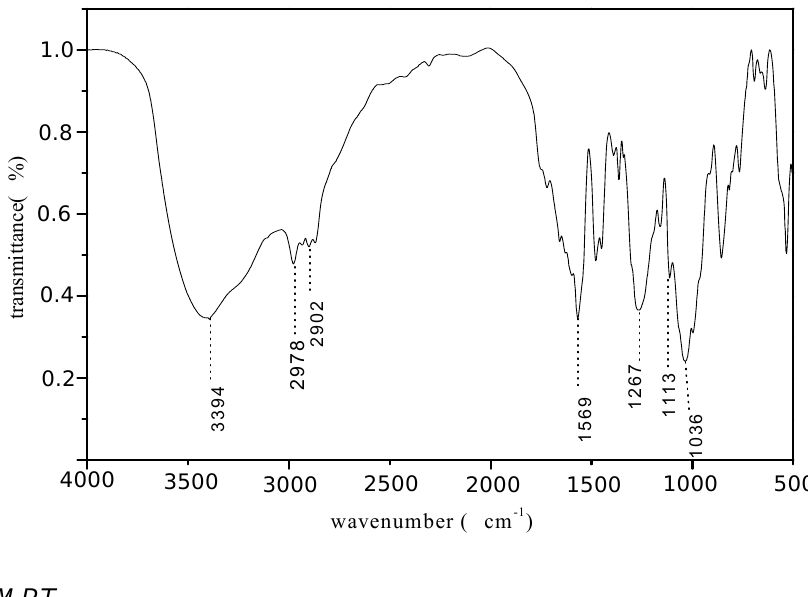
Figure 3. FTIR spectrum of phosphorus-containing triazine oligomer